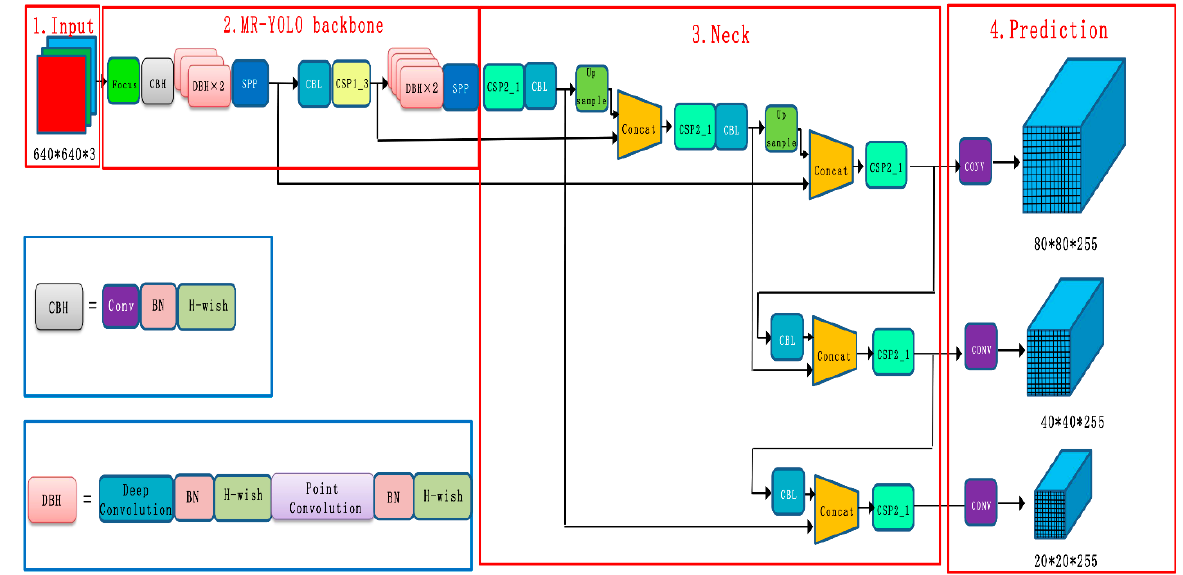
Figure 3. Network structure diagram of improved YOLOv5. The components DBH + CBH form the feature extraction network part. CBH: consists of three components Conv + BN + H-wish activation function. DBH: consists of two components depth separable convolution + point convolution.